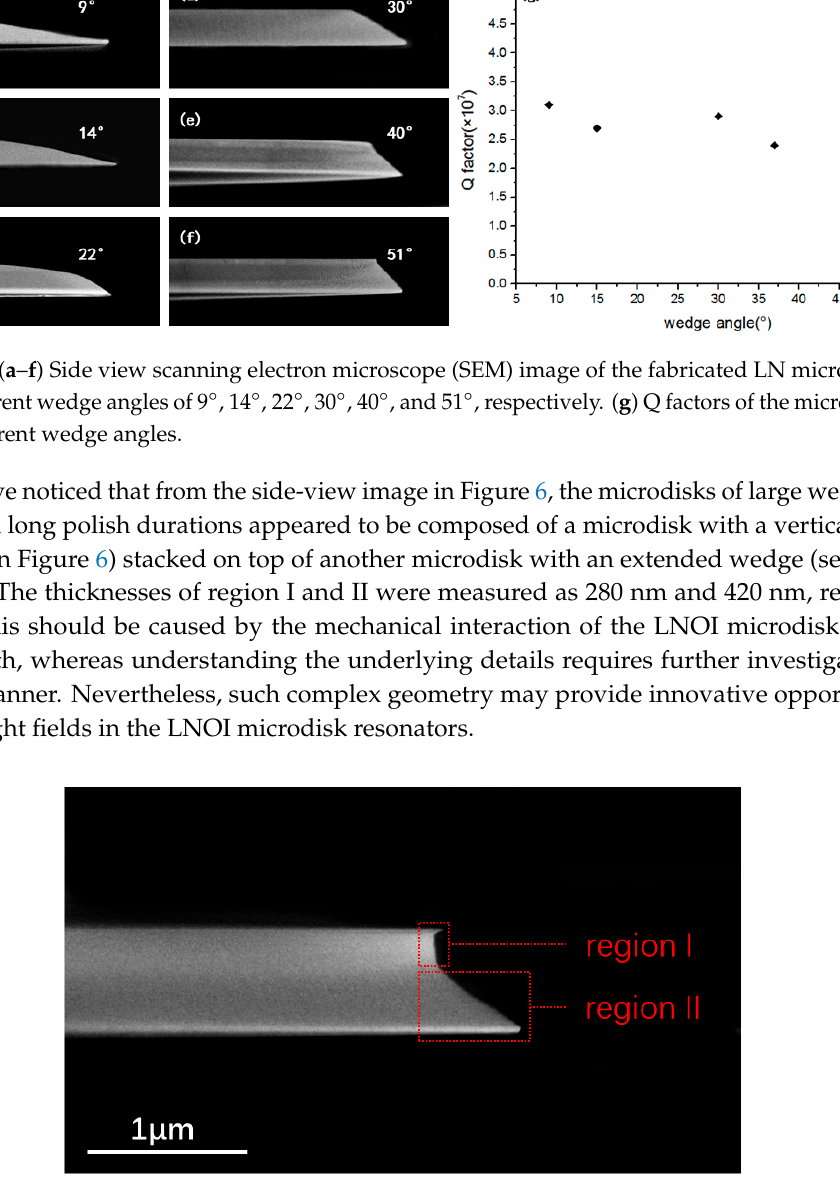
Figure 6. Side view scanning electron microscope (SEM) image of a fabricated LN microdisk resonator with a long polish duration of 90 min.